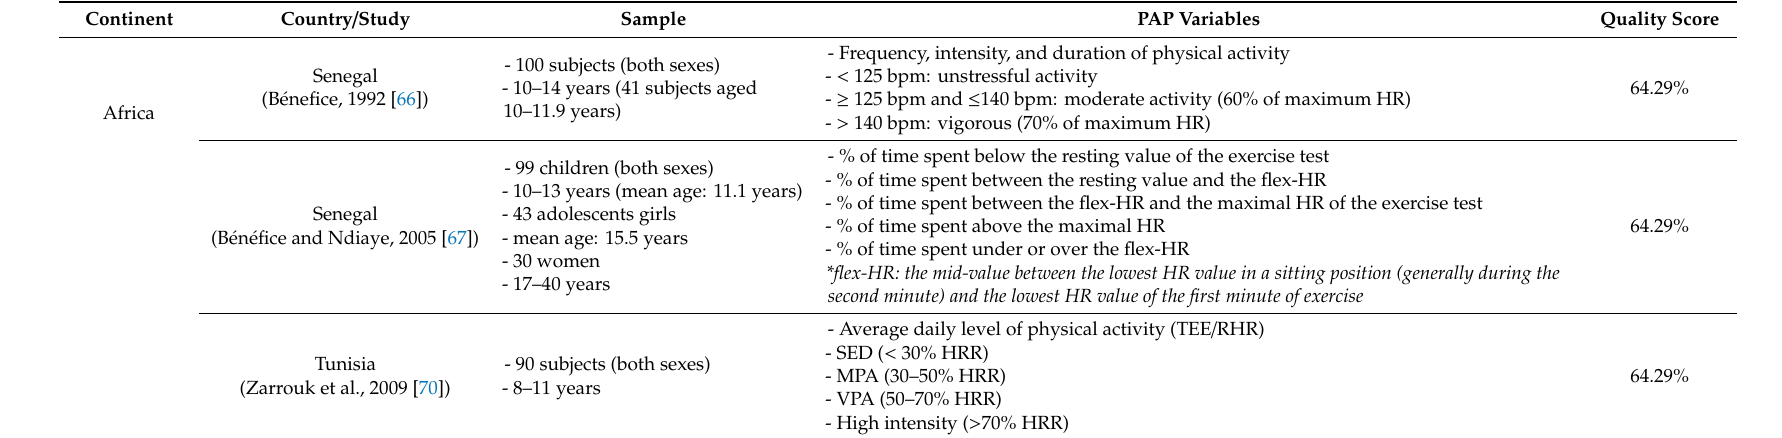
Table 4. Summary of the studies that used heart rate monitors to assess